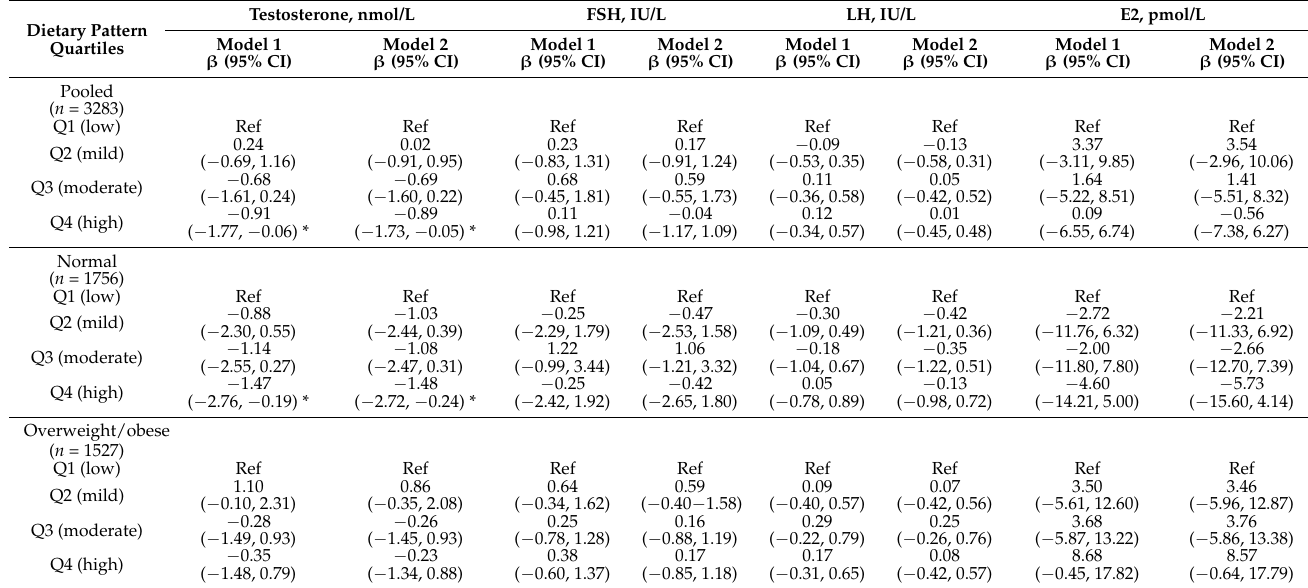
Table 4. Multivariate linear regression coefficients for sex hormones in relation to the dietary pattern quartiles according to nutrition status.